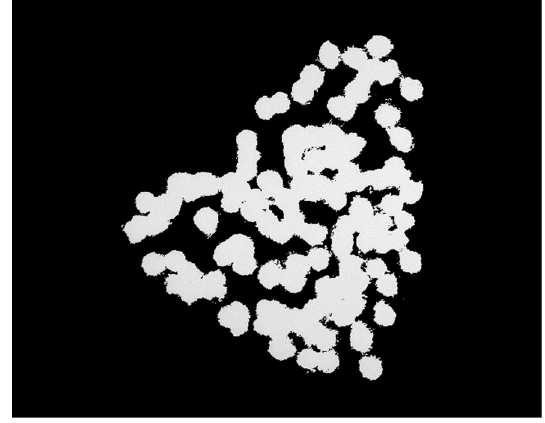
Figure 1. Pools of Light, map by Carter Crawford (from ([5], p. 53, used with permission). The usual “efficient” map would have located everything on the street onto a single sheet—that is, different marks for lamp posts, fire hydrants, street signs, trees. Our inefficient map concentrated on a single subject and rather than lamp posts, it brought the pools of light into view. No legend, no north arrow, no neat line, none of the usual apparatus. At last: a modernist feel! Maybe even a sense of poetry, something imagistic, a little like Pound’s “The apparition of these faces in the crowd;/Petals on a wet, black bough” [6] or Williams’s red wheel barrow, but as it might manifest on a map, a map attentive to the experience of place [7]. That’s when I knew we could write poems in maps. That’s when I began thinking seriously about a poetics of